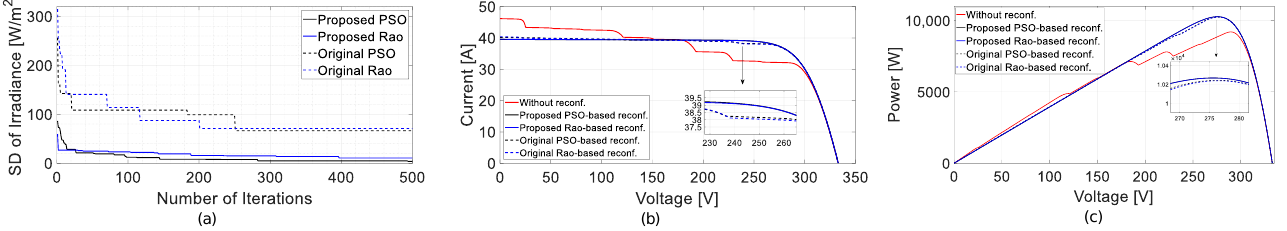
Figure 11. Shading distribution on PV array under the center of the cloud. ( a ) Before reconfigura- tion. ( b ) After original-PSO-based reconfiguration. ( c ) After the original-Rao-based reconfiguration. ( d ) After the proposed PSO-based reconfiguration. ( e ) After the proposed-Rao-based reconfiguration.